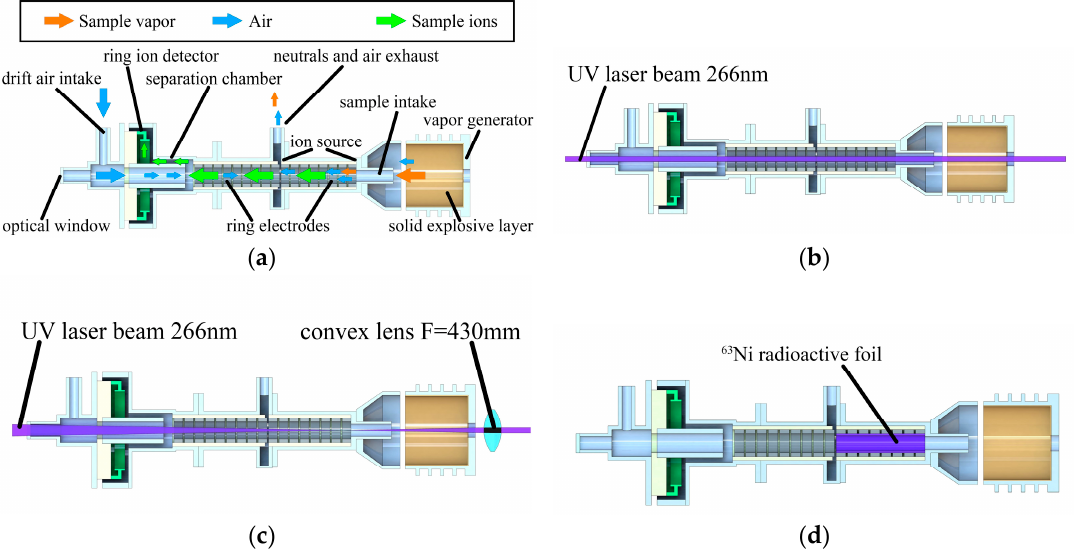
Figure 1. Schemes of field asymmetric ion mobility spectrometer (FAIMS): ( a ) Scheme of air, sample and ion flows inside FAIMS; ( b ) scheme of laser beam coaxial to ion source; ( c ) scheme of laser beam focusing and defocusing with convex lens; ( d ) scheme of placement of nickel radioactive foil inside ion source of the spectrometer. Table 1. Technical parameters of FAIMS.